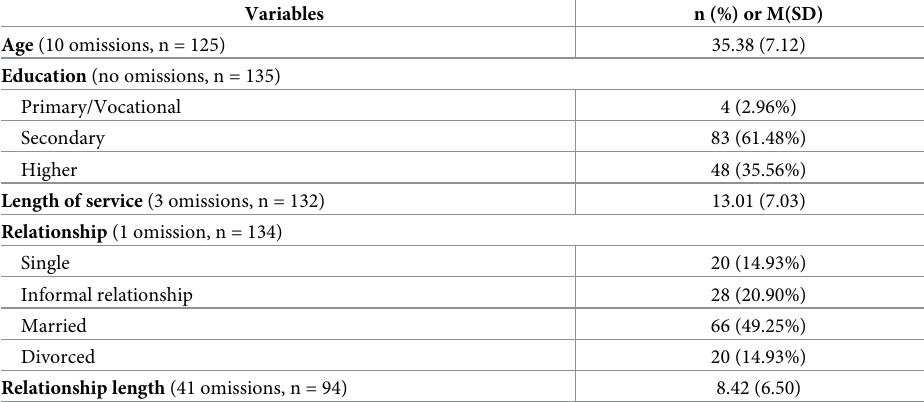
Table 1. Sociodemographic characteristics of the